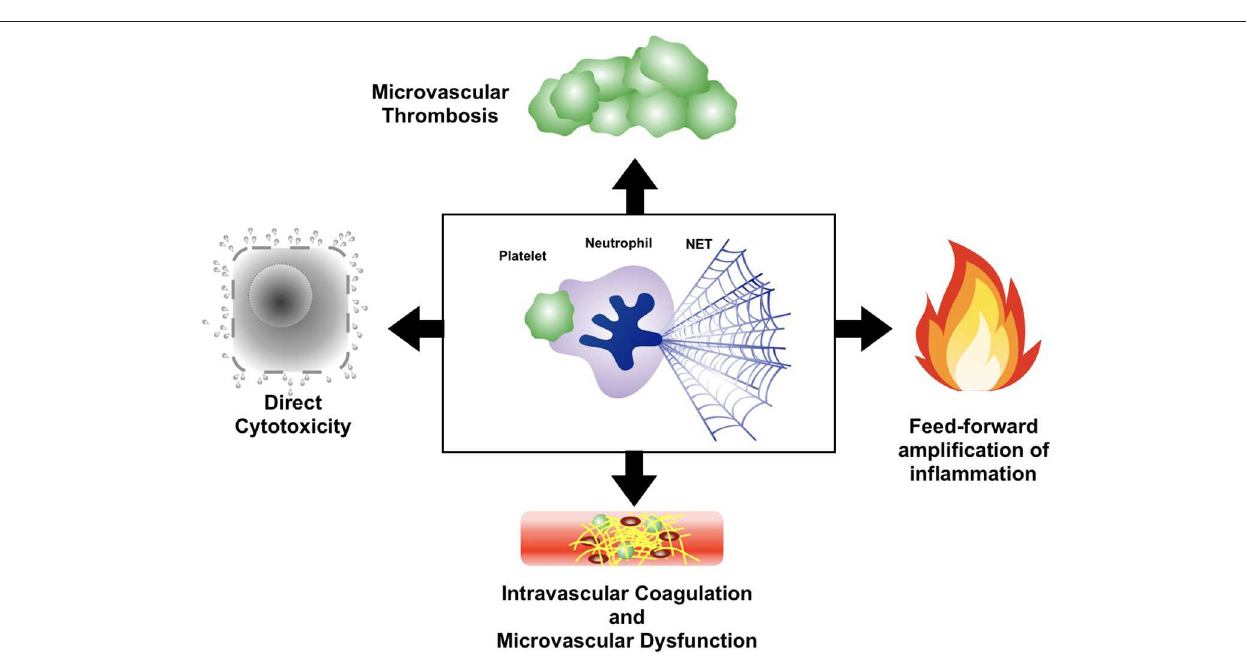
FIGURE 3 | Mechanisms of organ dysfunction in sepsis induced by the platelet-neutrophil-NETs axis. Intravascular collaboration between platelets, neutrophils, and NETs leads to cell and tissue damage as a result of directly cytotoxicity, induction of intravascular coagulation and microvascular dysfunction, and propagation of a dysfunctional thromboinflammatory response through feed-forward microvascular inflammation and thrombosis.